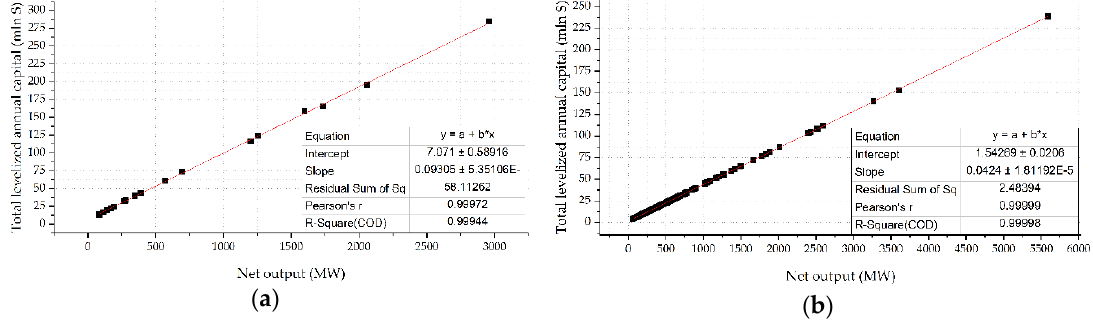
Figure 6 The relationship between the total levelized annual capital and the net output of the